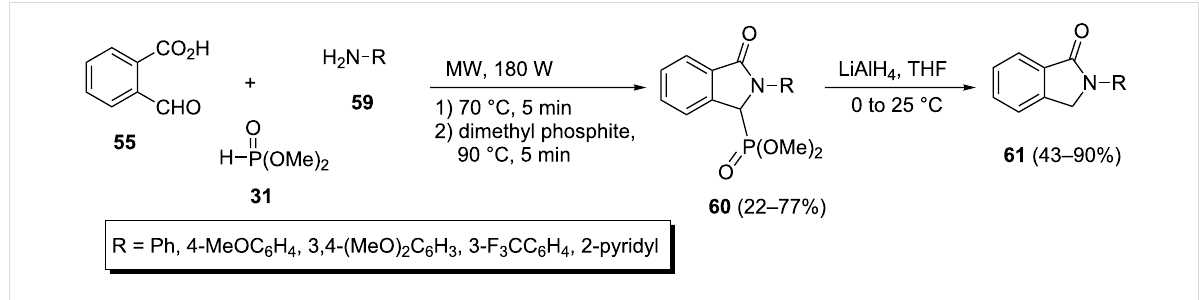
Scheme 15: A microwave-assisted Kabachnik–Fields reaction toward